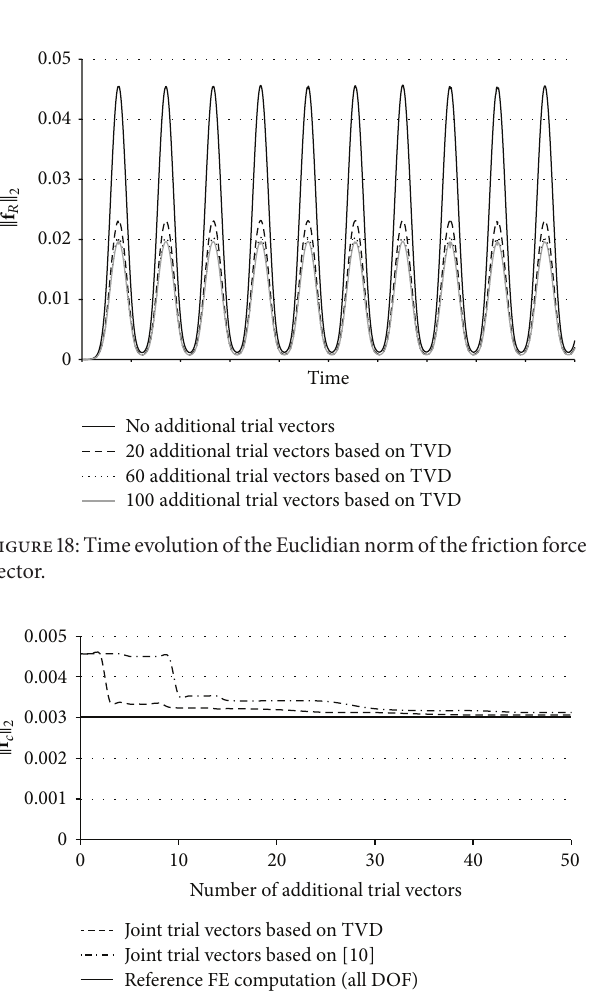
Figure 19: Multilayer sheet structure: convergence analysis for the static